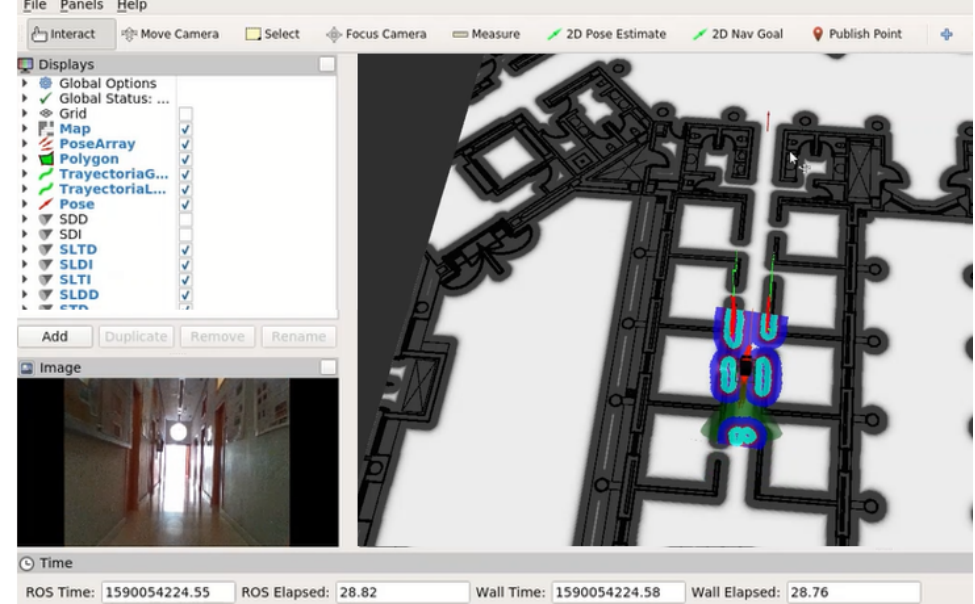
Figure 22. Indoor environment ROS navigation tests. SARA configuration with the 3D